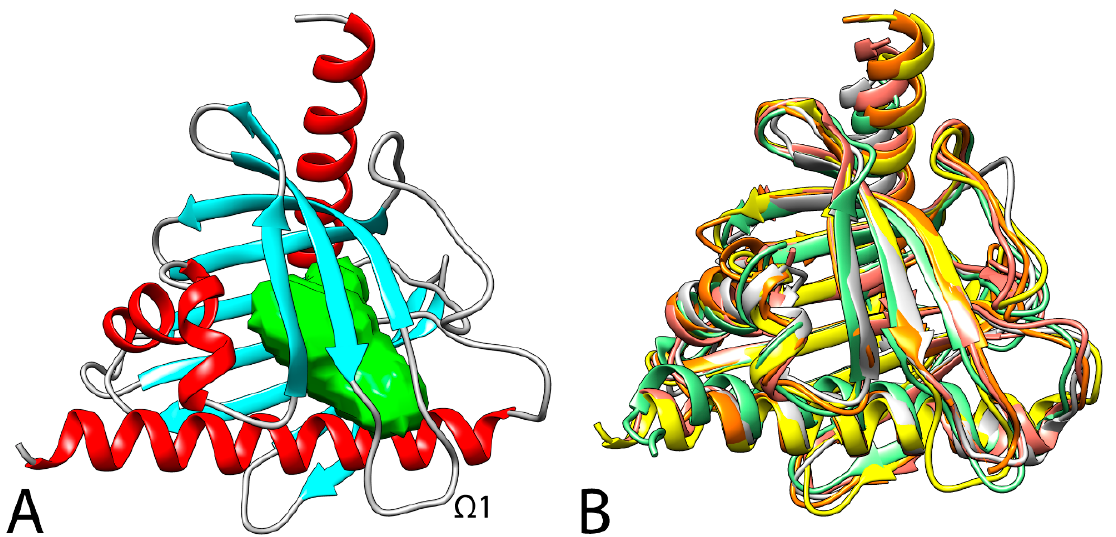
Figure 2. ( A ) 3D structure of STARD3 (5I9J). The cavity of the cholesterol binding pocket is colored in green. ( B ) Superim- position between the secondary structure of STARD1 (3P0L, orange [145]), STARD3 (5I9J, yellow [146]), STARD4 (6L1D, white [147]), STARD5 (2R55, salmon [148]), and STARD6 (2MOU, green [149]). RSMD values for the alignments compared with STARD3: STARD1, 1.3 Å; STARD4, 2.8 Å; STARD5, 2.7 Å; STARD6, 3.0 Å.